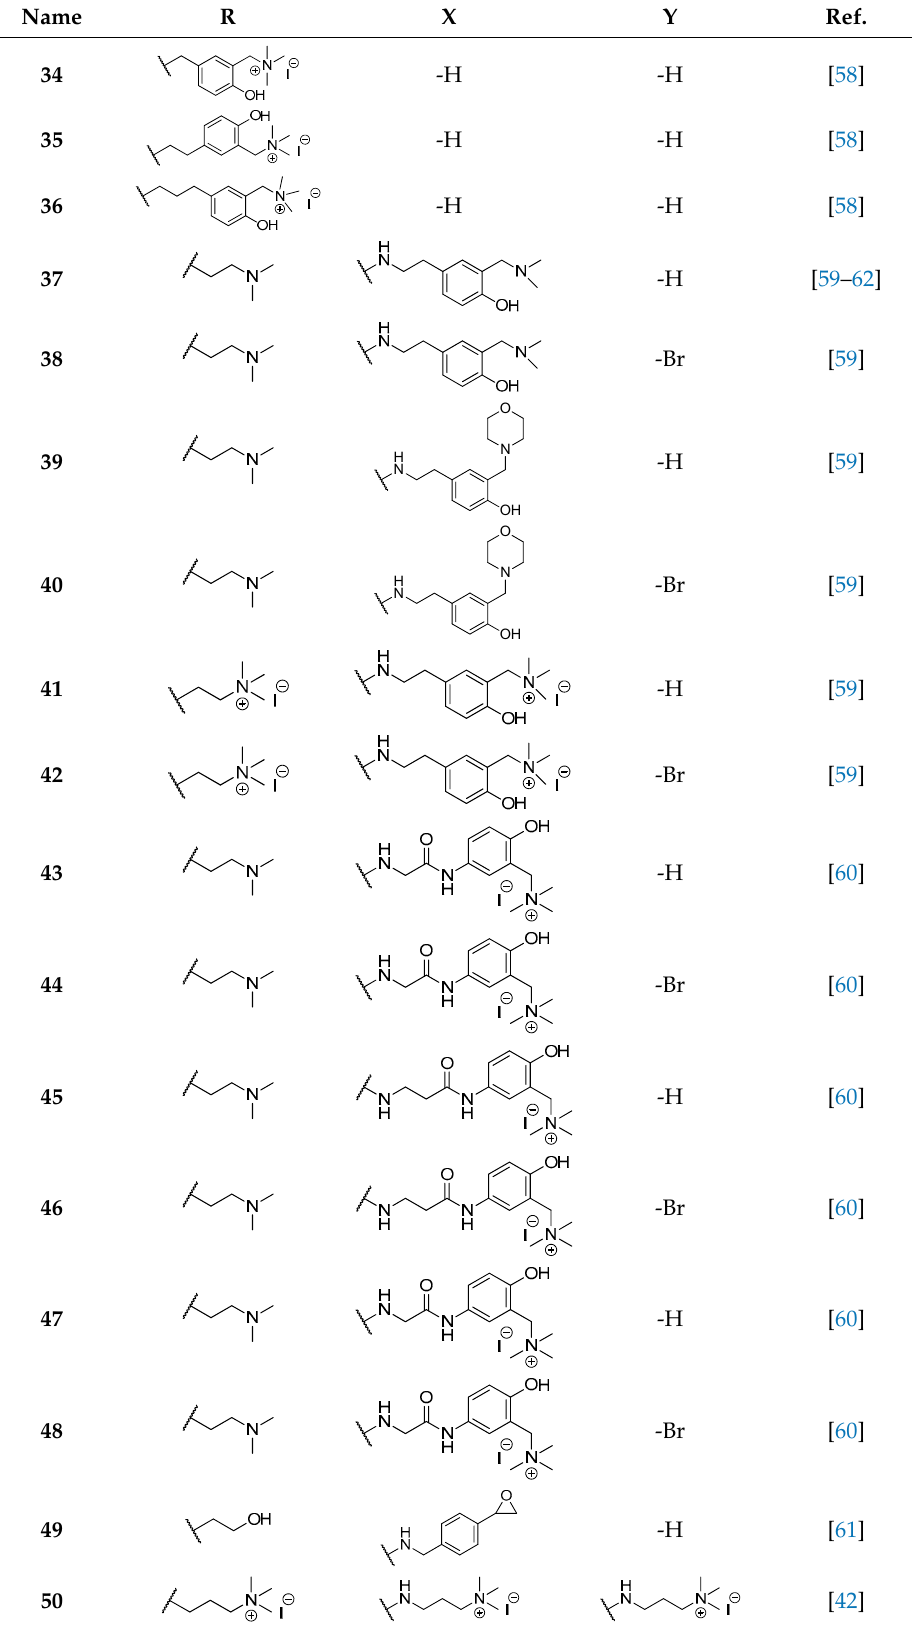
Table 1. Structures of NDIs used as reversible ligands to stabilize telomeric G4s. Table 2. Structures of NDIs used as irreversible ligands to stabilize/modify telomeric G4s.